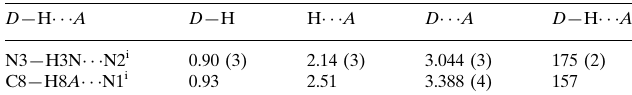
Hydrogen-bond geometry (A˚ , (cid:1)